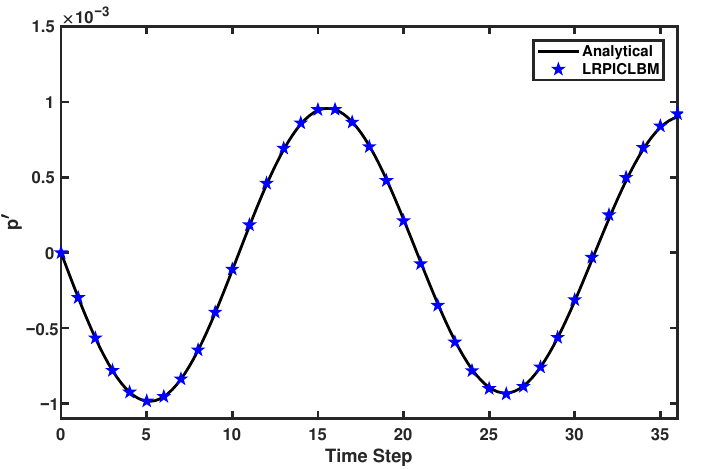
∆ x 2 ∆ t ) with N ppw = 12